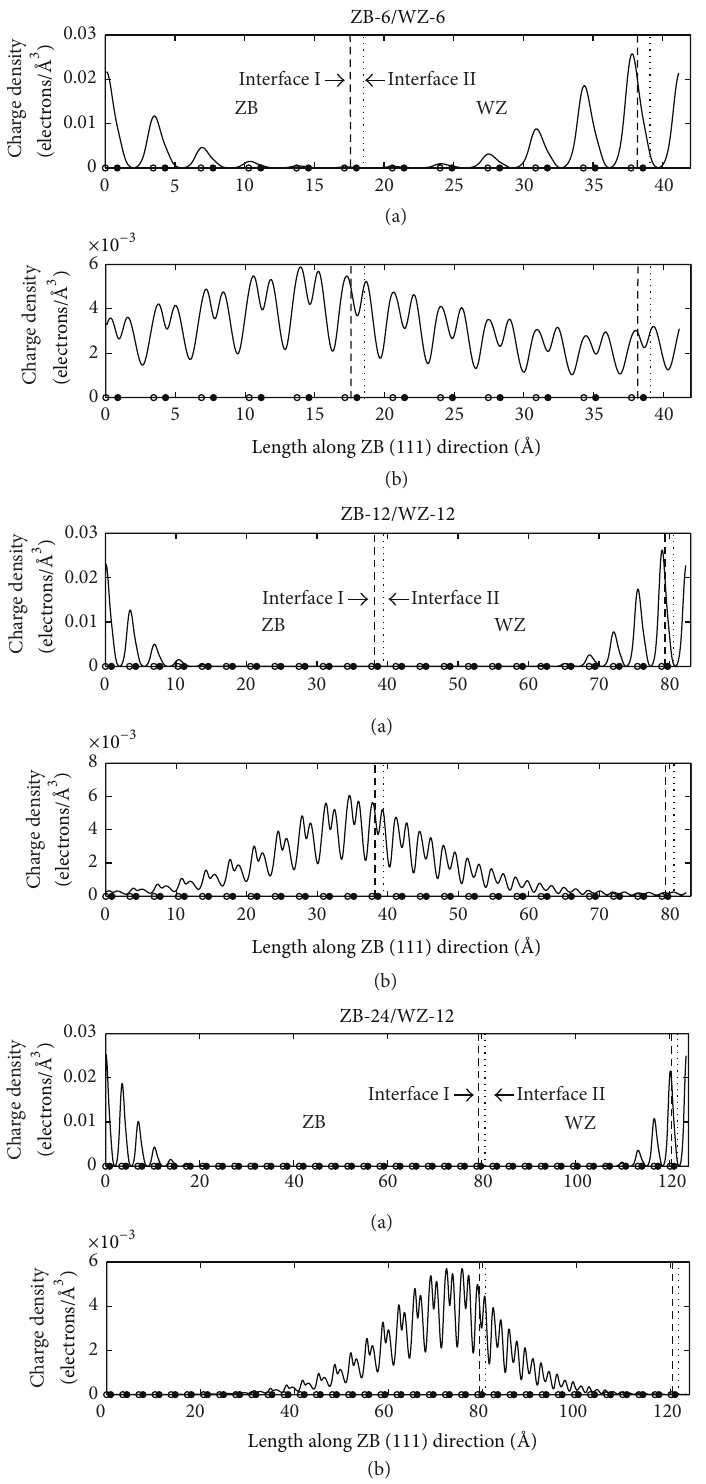
Figure 3: Plane-averaged charge densities of (a) VBM and (b) CBM states in three CdS ZB/WZ heterocrystalline superlattices (ZB-6/WZ-6, ZB-12/WZ-12, and ZB-24/WZ-12). For empty and solid circles and vertical dashed and dotted lines, please see Figure